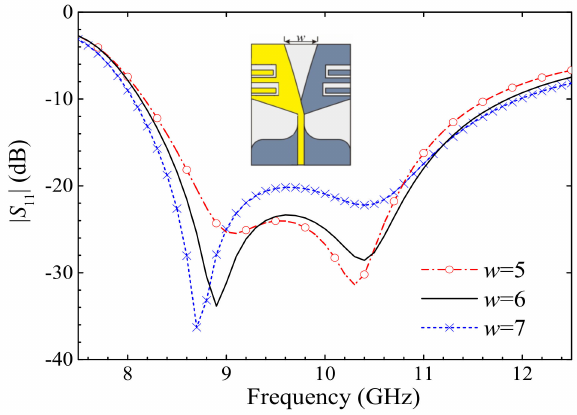
Figure 4. | S 11 | of the designed antenna with different w (unit: mm).